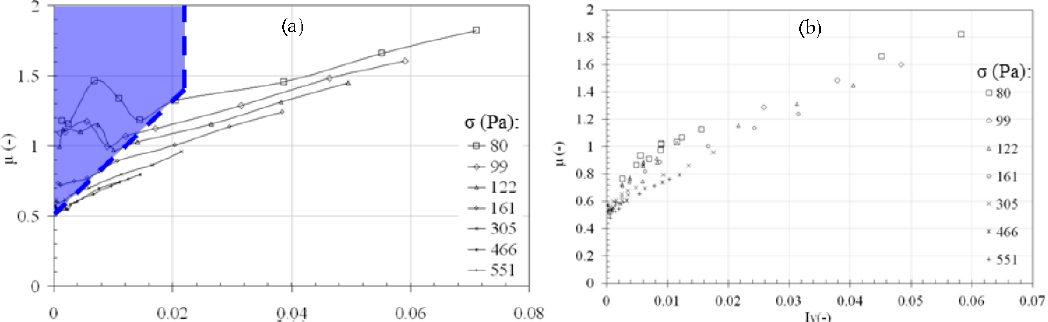
Figure 6. Irregular plastic particle–glycerin solution C. Friction coefficient µ as a function of the viscous number I v . ( a ) full data. The fill marked area corresponds to the lower shear rate and lower normal imposed pressure values (i.e., partially shearing condition). ( b ) filtered data corresponding to simple shearing condition